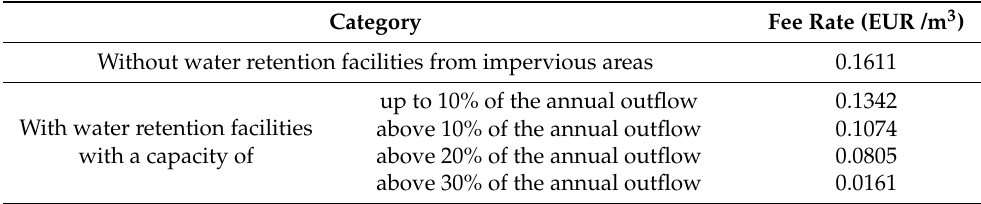
Table 1. The level of fee rates in 2022 depending on the capacity of the facilities related to annual runoff [41]. Category Fee Rate (EUR /m 3 ) Without water retention facilities from impervious areas 0.1611 up to 10% of the annual outflow 0.1342 With water retention facilities above 10% of the annual outflow 0.1074 with a capacity of above 20% of the annual outflow 0.0805 above 30% of the annual outflow 0.0161